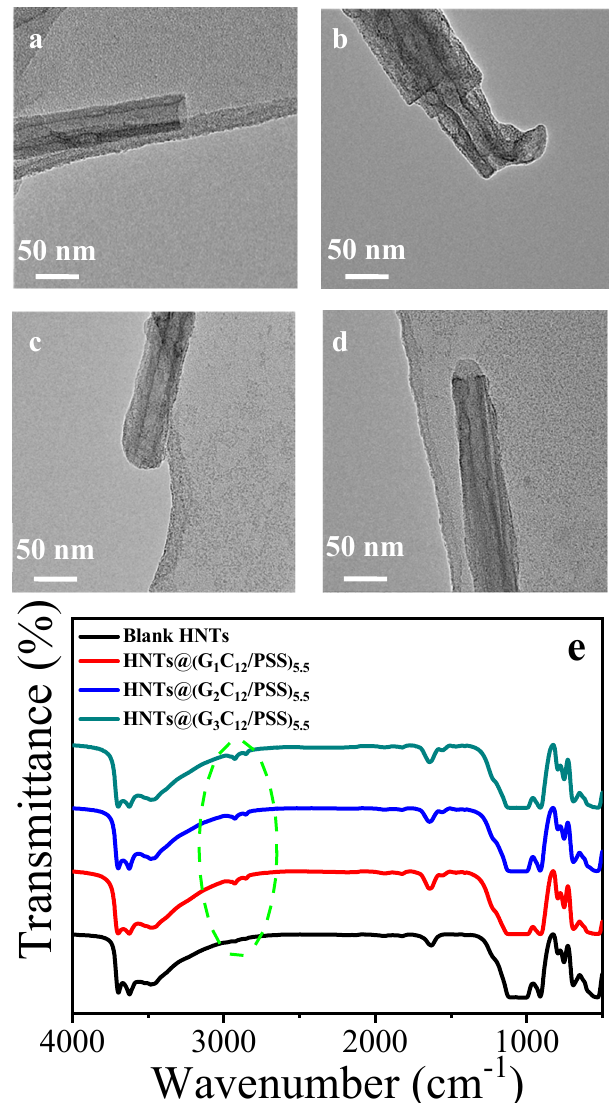
Figure 2. TEM images of ( a ) bare HNTs, ( b ) HNTs@(G 1 C 12 / PSS) 5.5 , ( c ) HNTs@(G 2 C 12 / PSS) 5.5 , ( d ) HNTs@(G3C12/PSS)5.5. ( e ) FTIR spectra of bare HNTs, HNTs@(G 1 C 12 /PSS) 5.5 , HNTs@(G 2 C 12 /PSS) 5.5 , and HNTs@(G 3 C 12 /PSS) 5.5 .